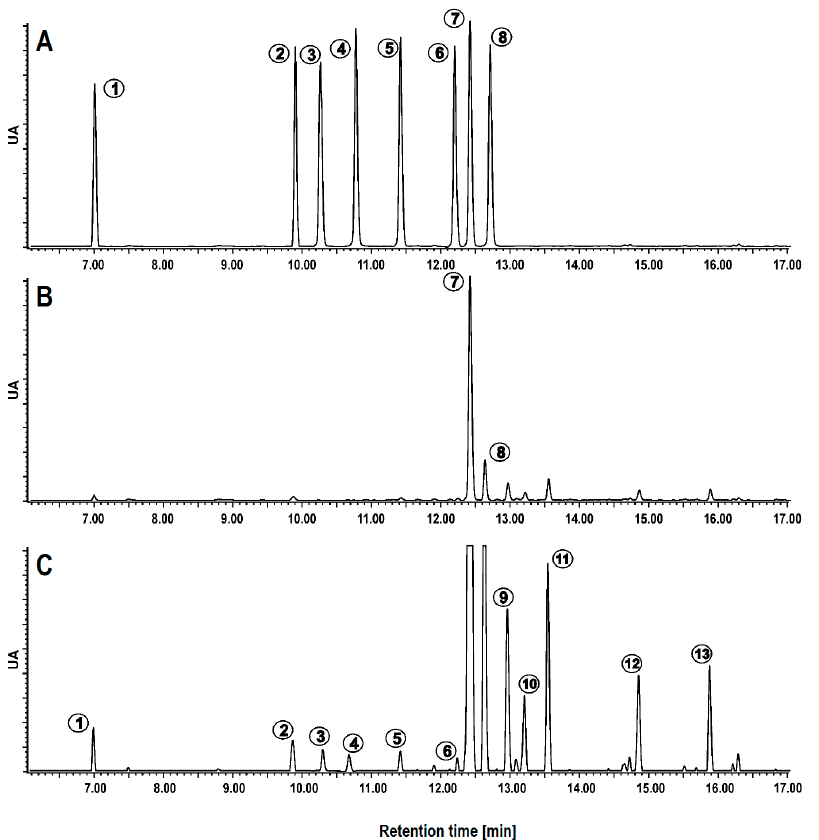
Figure 2. The chromatogram of free phenolic acids (PAs) of triticale. ( A )—Mixture of eight phenolic acid standards, ( B )—Chromatogram of triticale extract, ( C )—Chromatogram of triticale enlarged 6 times to show minor compounds, ( 1–13 )—Compounds’ numbers correspond to Table 1.